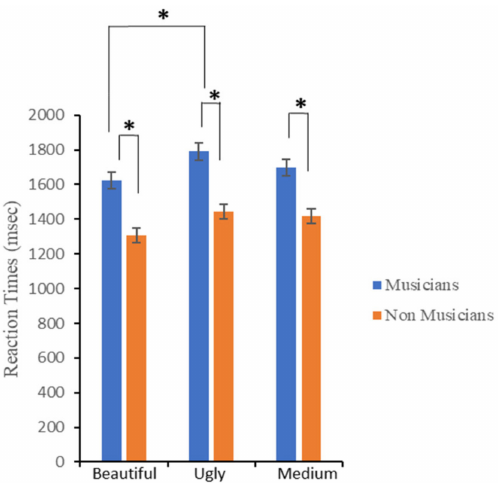
Figure 3. Participants’ mean reaction times (ms) for the esthetic evaluation. Error bars repre- sent ± 1 SEM. Asterisks represent significant